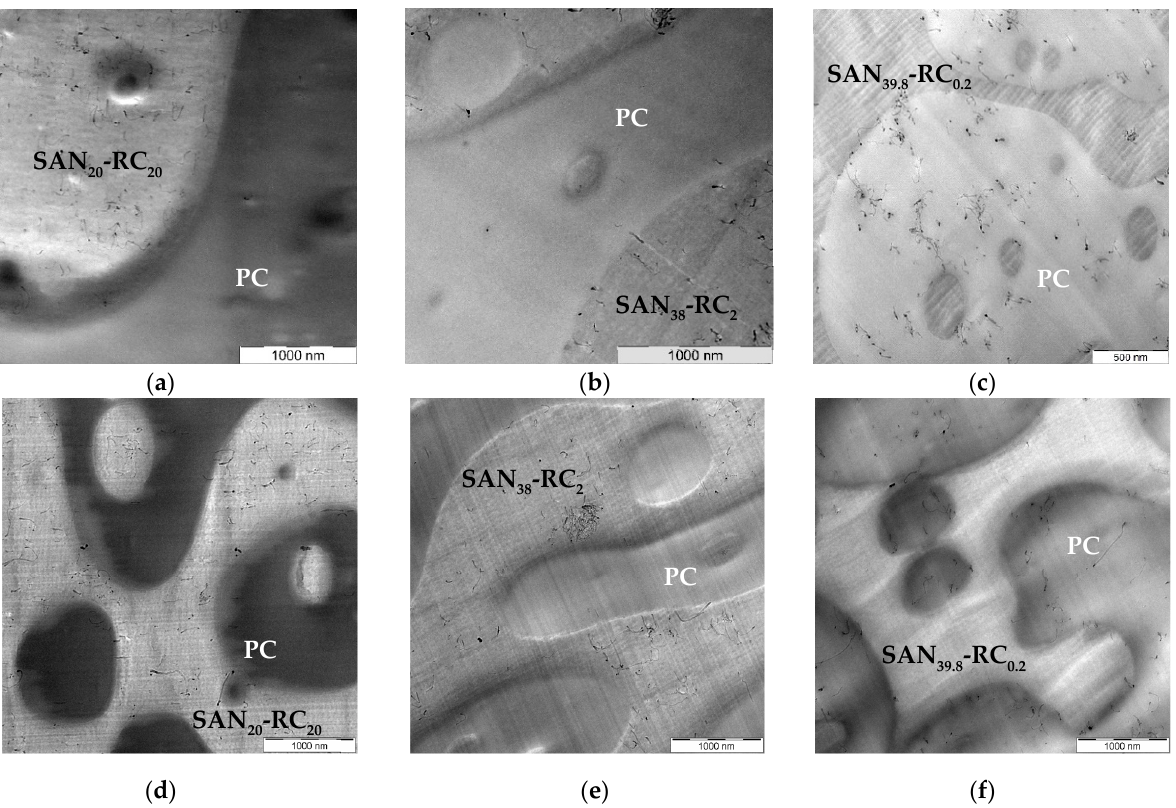
Figure 1. TEM images of PC 60 /SAN 40 -x-RCx blends filled with NC3150 ( a – c ) and NC7000 ( d – f ): (a) PC 60 /SAN 20 -RC 20 blends and (b) PC 60 /SAN 38 -RC 2 blends illustrating NC3150 (0.5 wt. %) in SAN-RC; and (c) in PC 60 /SAN 39.8 -RC 0.2 blends NC3150 (0.5 wt. %) stay in PC; (d) PC 60 /SAN 20 -RC 20 blends and (e) PC 60 /SAN 38 -RC 2 blends showing NC7000 (0.5 wt. %) in SAN-RC; and (f) in PC 60 /SAN 39.8 -RC 0.2 blends NC7000 (0.5 wt. %) stay in PC.